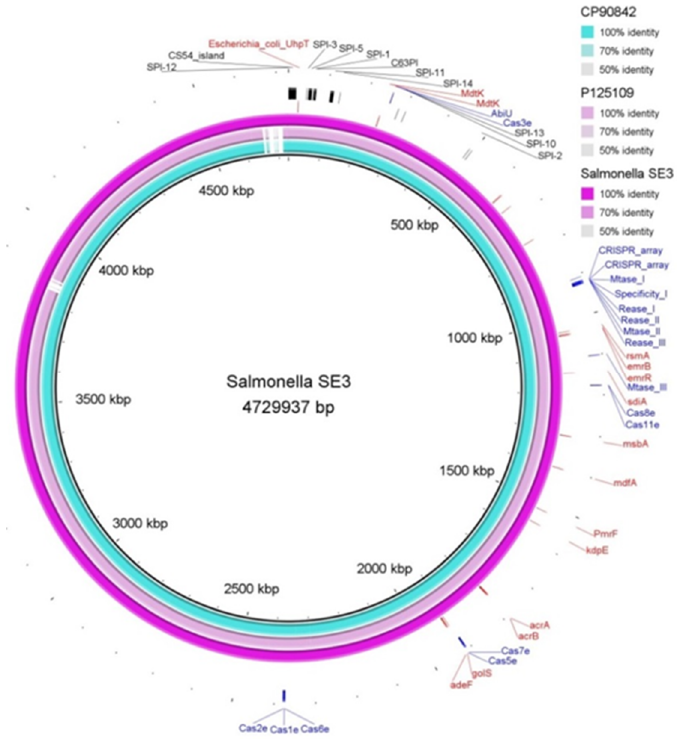
Figure 4. Salmonella SE3 antimicrobial resistance genes (red color), Salmonella Pathogenic Island (SP) (black color) and defense system (blue color) with two genomes of reference of Salmonella serovar Enteritidis (P125109 and CP9084.2).